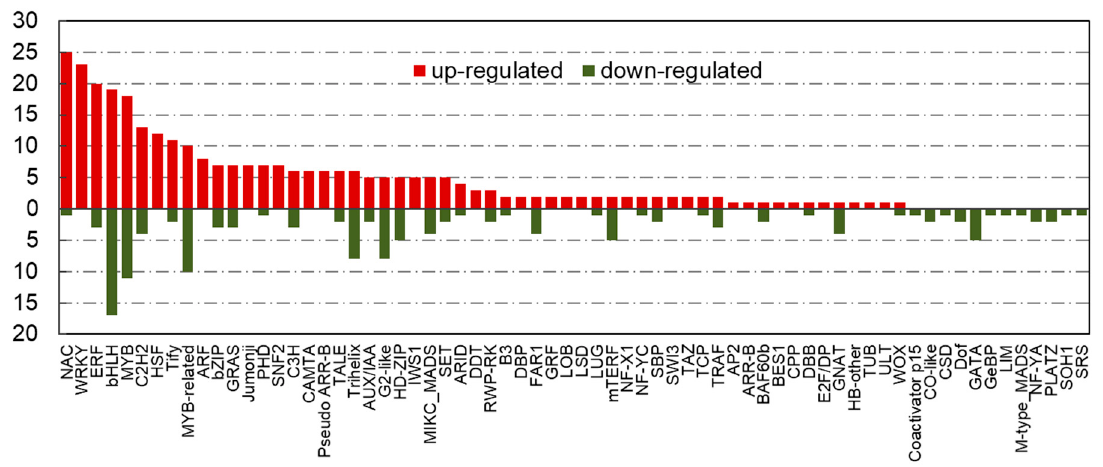
Figure 3. The number of differentially expressed transcriptional factors in “cold-tolerant transcription factor (TF) set” under cold stress. X-axis indicates various transcription factor families; Y-axis indicates the number of differentially expressed transcriptional factors. Red bars indicate upregulated; green bars indicate downregulated.